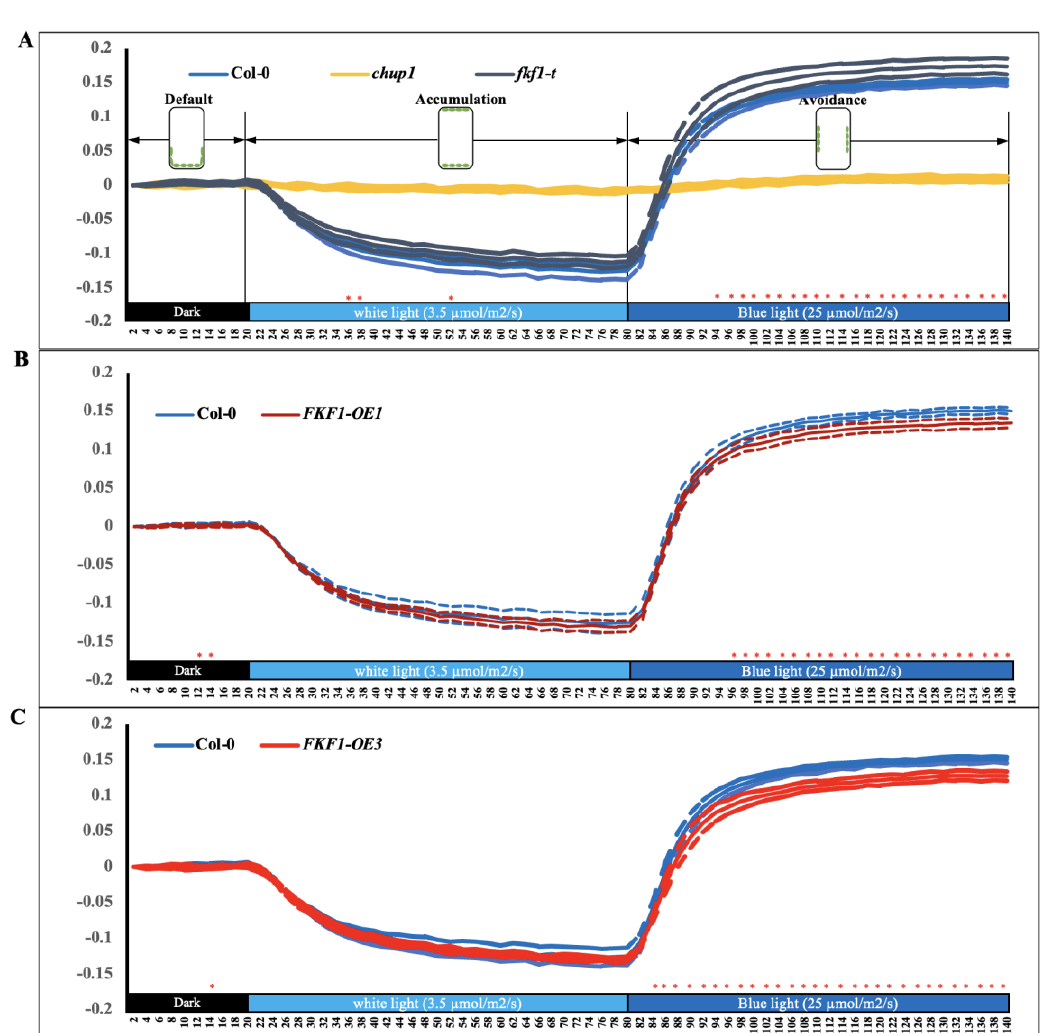
Figure 3. Chloroplast relocation studies using a red light transmittance assay under white light and monochromatic blue light. A red-light transmittance assay was performed to investigate the photorelocation of different Arabidopsis lines, evaluating the chloroplast movement in the Col-0, chup1, fkf1-t , and FKF1 OE lines in response to sequential treatments of white light and monochromatic blue light. Red-light transmittance was measured for 20 min in dark adapted leaves to establish a baseline, followed by sequential 60 min treatment of 3.5 µmol/s/m 2 white light and 60 min treatment of 25 µmol/m 2 /s monochromatic blue light. Red-light transmittance was recorded every 2 min. The data are an average of red transmittance changes from 6 independent leaves collected from 6 different plants. Dashed lines represent S.D. ( n = 6). Welch’s t test was used to test the difference between the means from two groups. Statistically significant differences between the Col-0 and any other Arabidopsis lines are labeled with * ( p < 0.05). The diagram shows the expected positions of chloroplasts under different light conditions in Col-0. Y-axes : Δ red-light transmittance; X-axes: time in min.